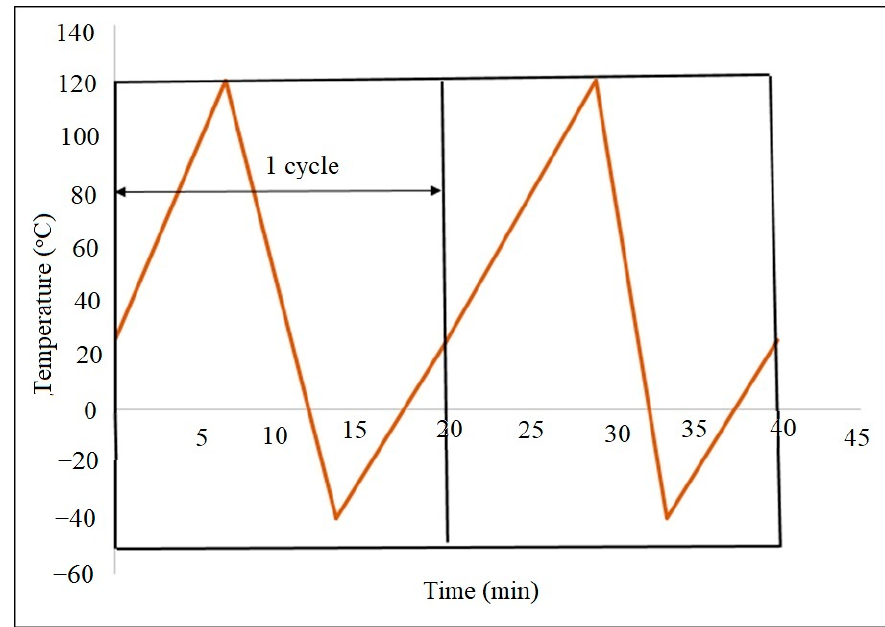
Figure 3. Temperature profile of thermal-cycling process for two cycles.